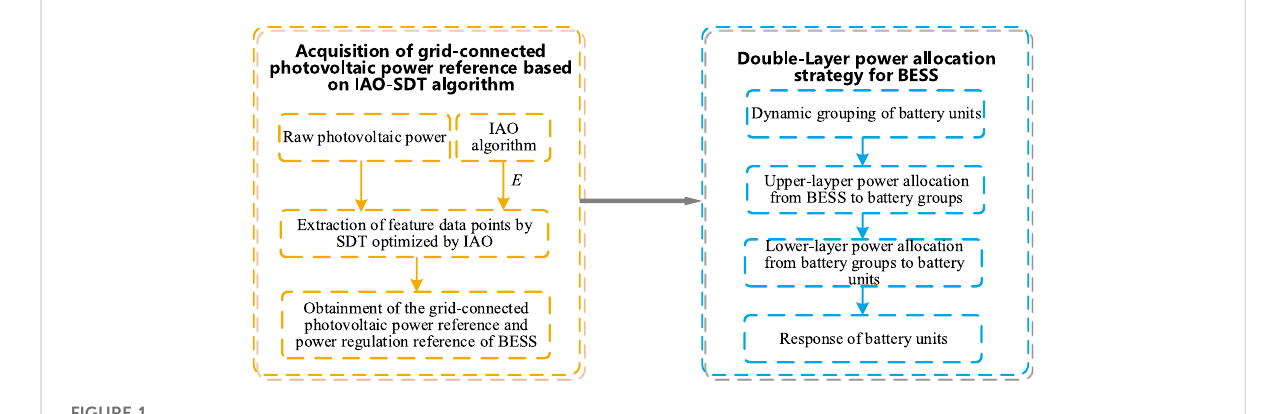
FIGURE 1 Hierarchical structure and implementation process of this